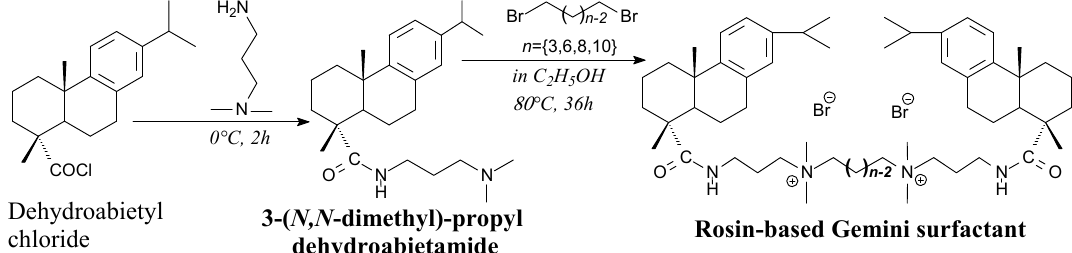
Scheme 33. Synthesis of rosin-based gemini